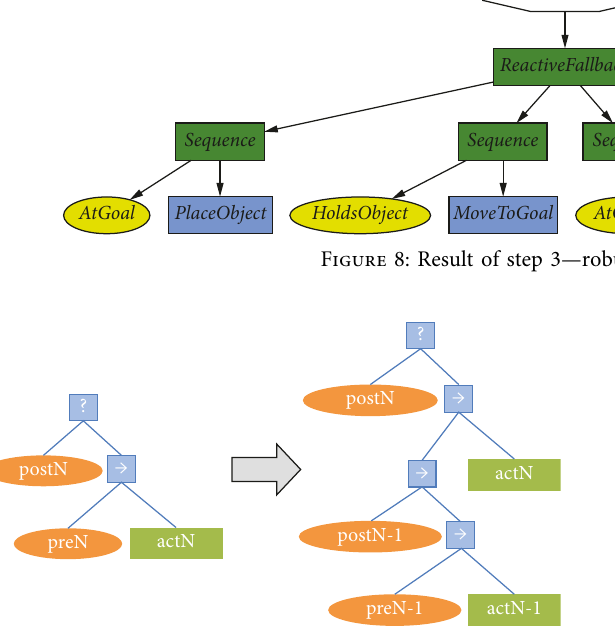
Figure 9: Expanding the BT using backward chaining.